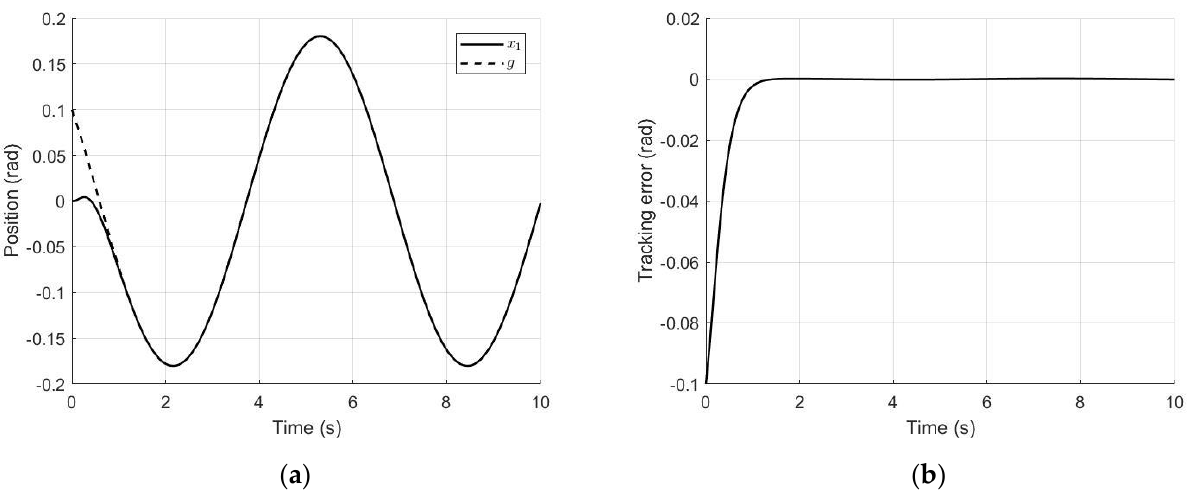
() x t ; in ( b ), plot 1